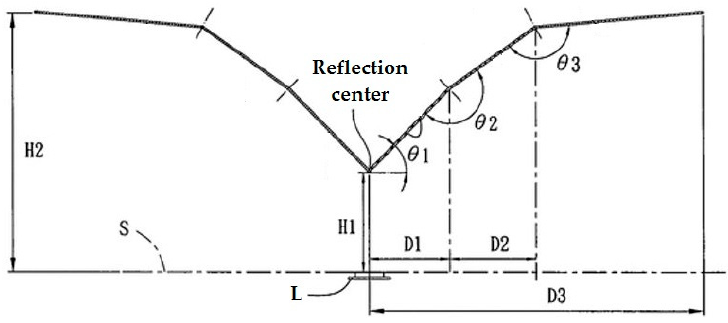
Figure 3. Mechanical drawing of the used reflector in the proposed system and its characteristic parameters.